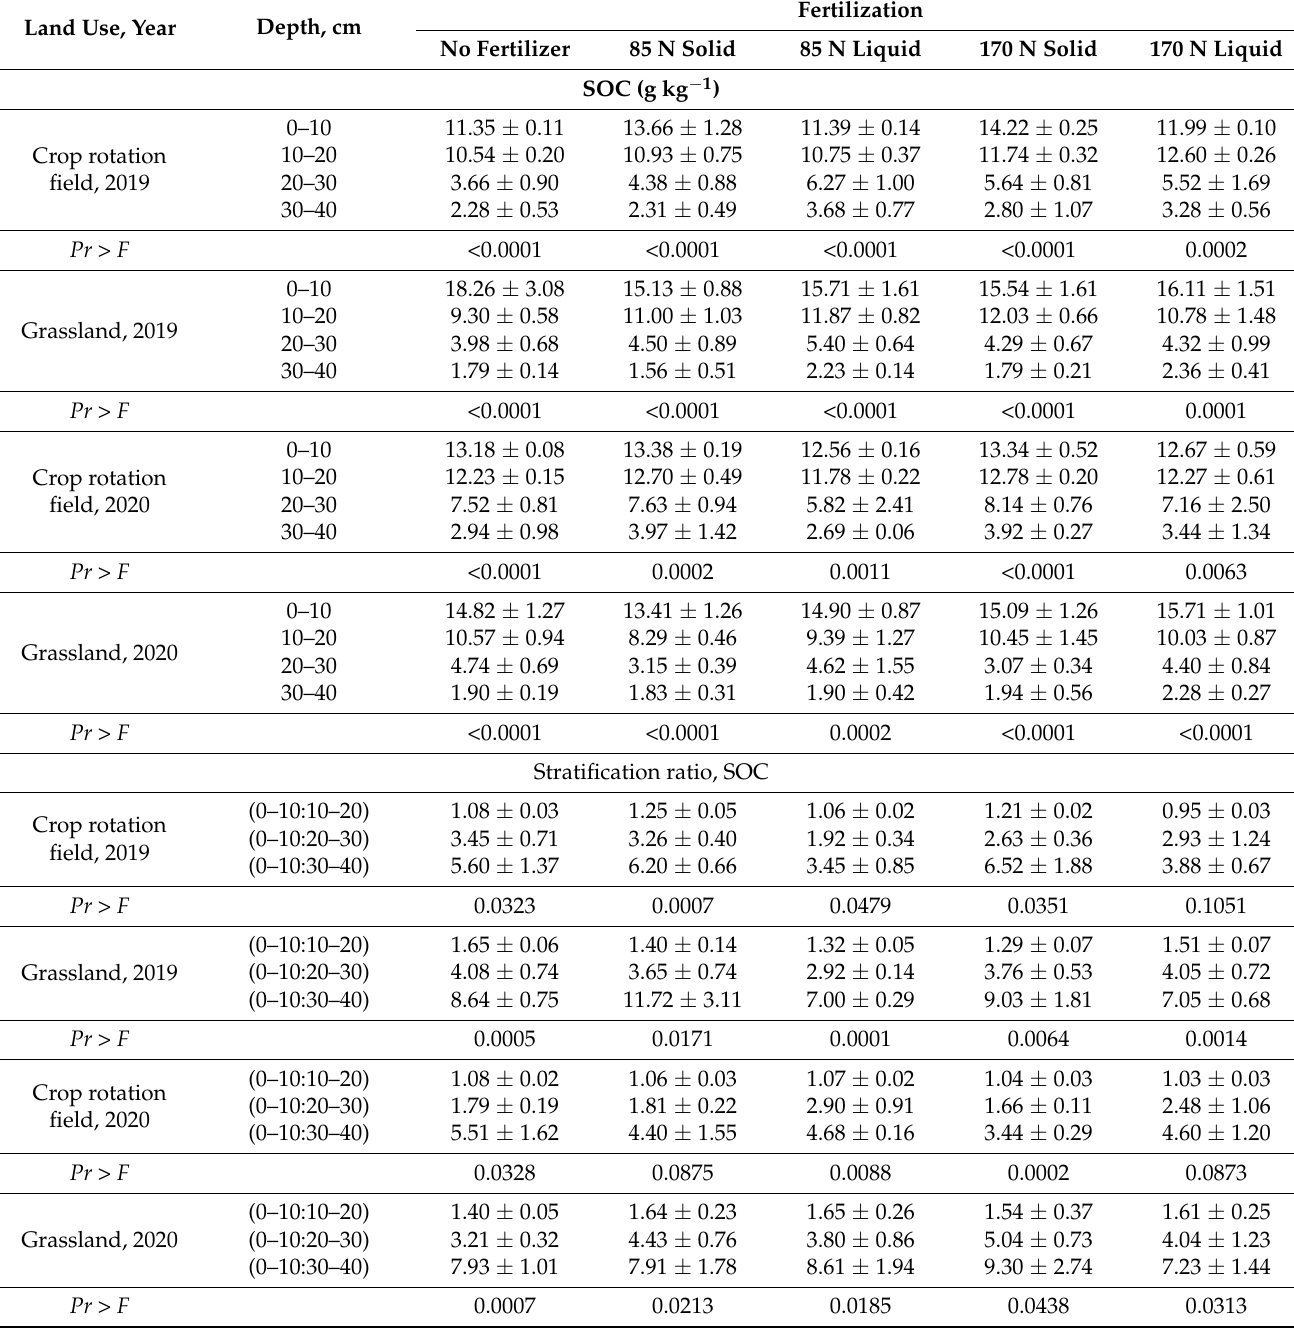
Table 1. Stratification ratios of SOC in digestate-treated soils under two land-use systems in 2019 and